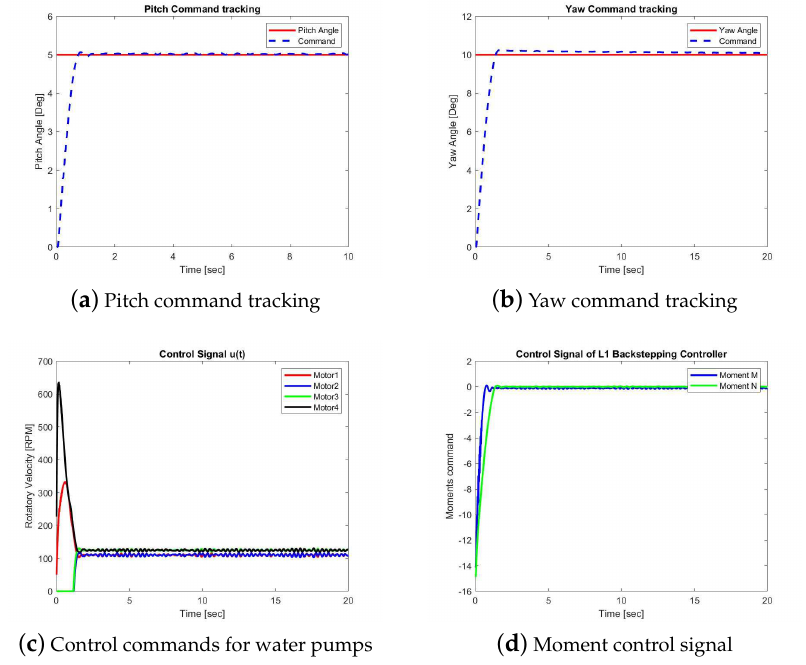
Figure 6. Case 2A: Simulation results of the L 1 backstepping control.